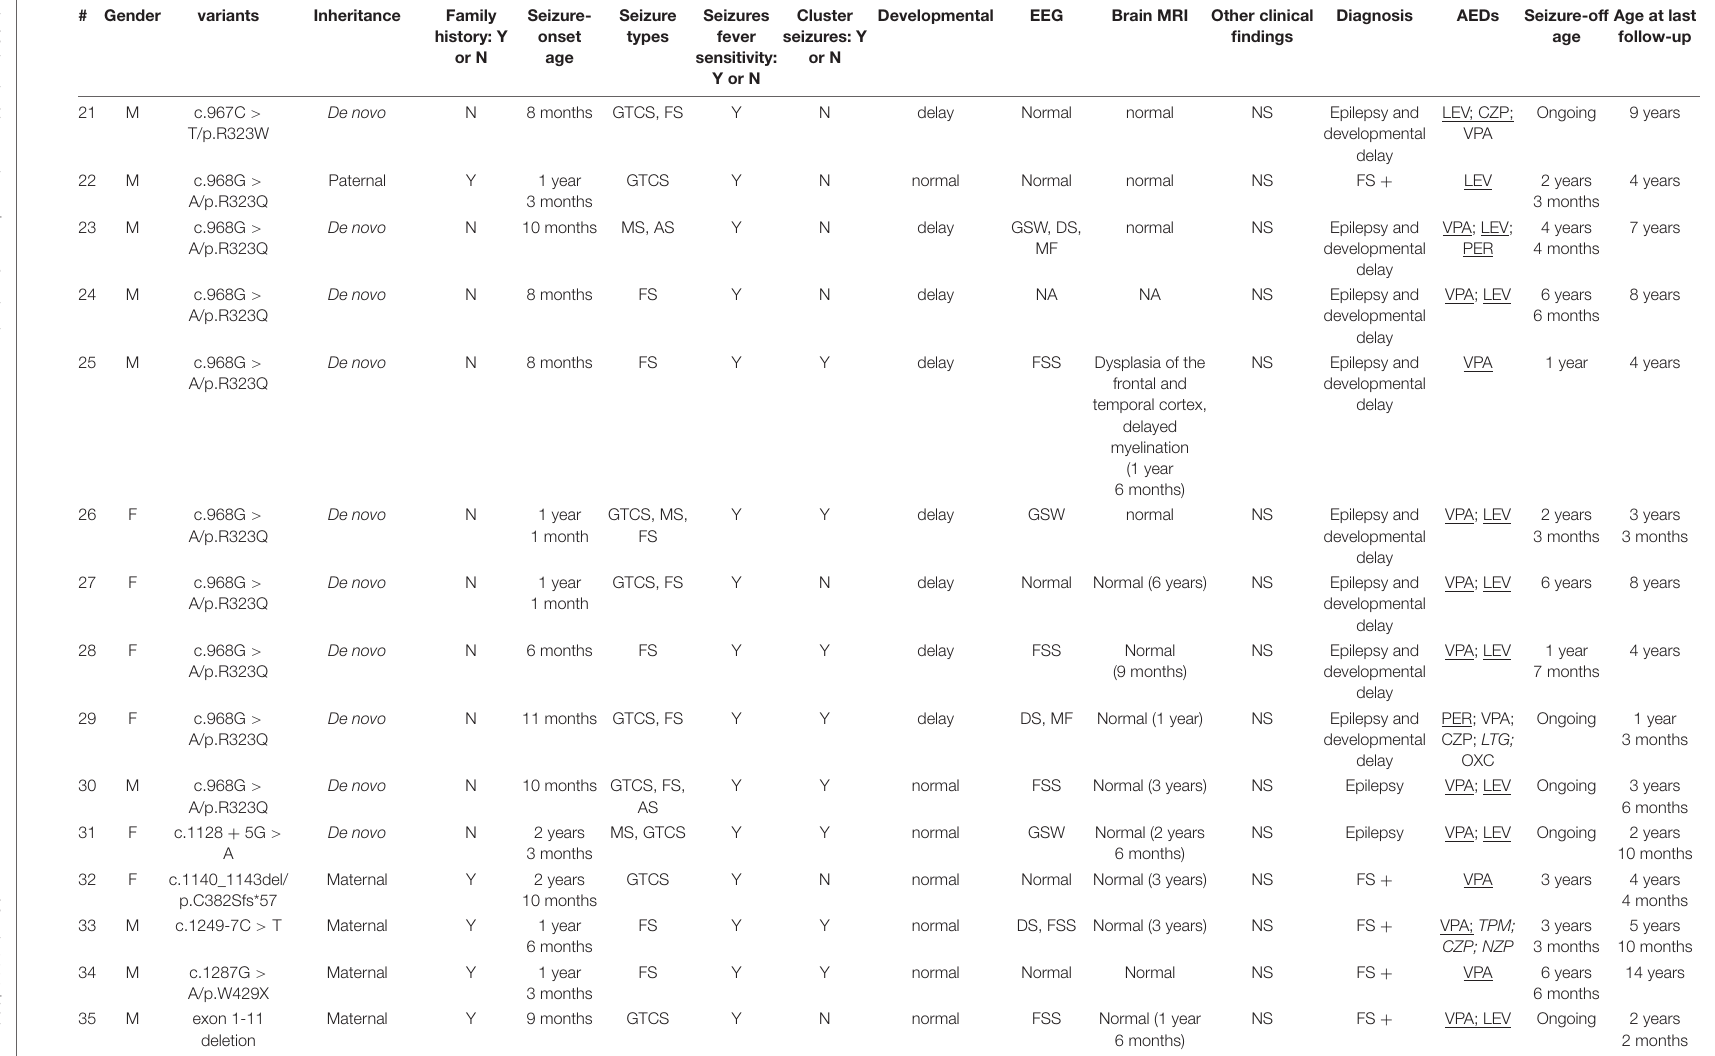
F, female; M, male; AS, absence seizure; C, clonic seizure; DEE, developmental and epileptic encephalopathy; FS, focal seizure; GTCS, generalized tonic-clonic seizure; MS, myoclonic seizure; SE, status epilepticus; T, tonic seizure; TC, tonic-clonic seizure; NA, not applicable; NS, no specific. EEG, electroencephalography; DS, diffuse slowing; FSS, focal spike slow waves; MF, multifocal; GSW, generalized spike wave; GFW, generalized fast wave; MRI, magnetic resonance imaging; ASD autistic spectrum disorder; AED, anti-epileptic therapy; LEV, levetiracetam; VPA, valproic acid; TPM, topiramate; CLB, clobazam; VGB, vigabatrin; DZP, diazepam; PB, phenobarbital; PER, Perampanel; CZP, clonazepam; KD, ketogenic diet; OXC, oxcarbazepine. Underlining indicates treatment with clinical response (decreased seizure frequency or severity), and italics indicates a negative response (aggravation of seizure frequency and/or